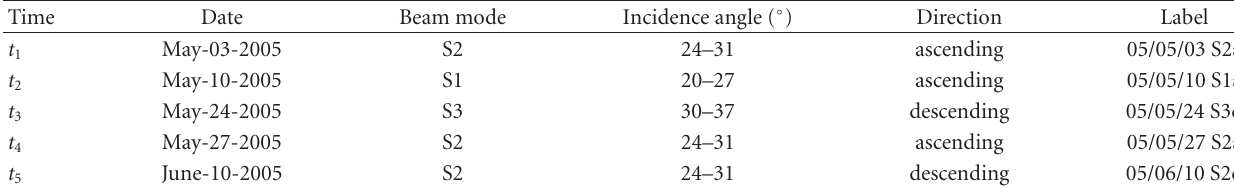
Table 2: RADARSAT-1 images used in this